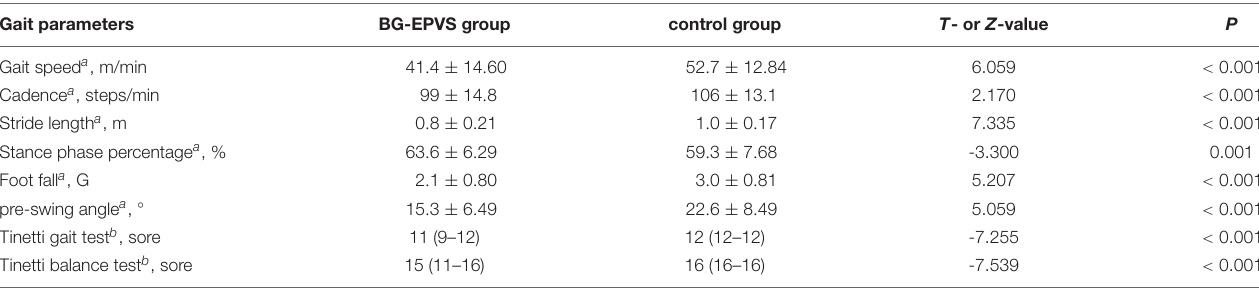
TABLE 2 | Gait parameters of the enlarged perivascular spaces in the basal ganglia (BG-EPVS) group and the control